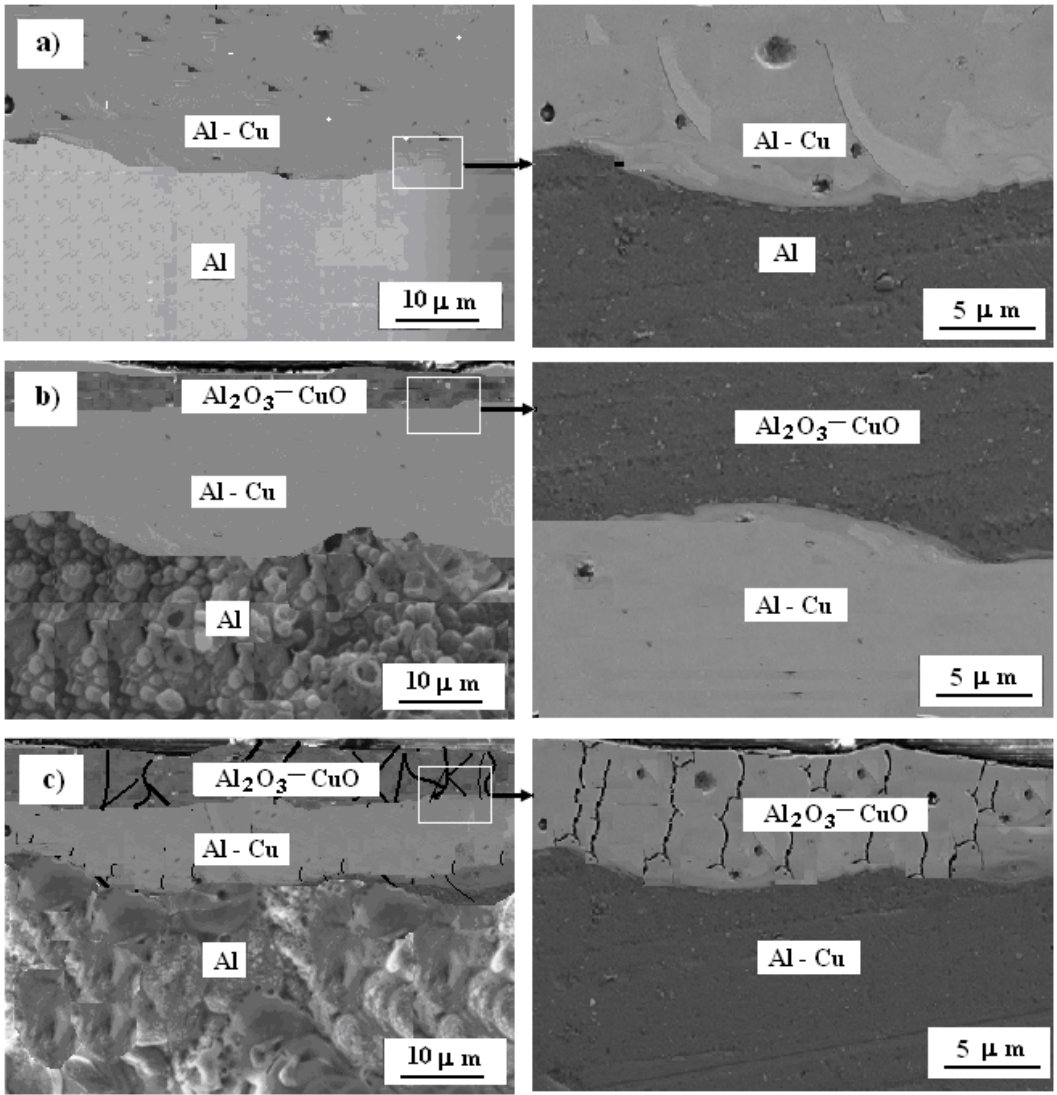
Figure 7. SEM images of cross-section of samples: ( a ) before and after heat treatment at: ( b ) 400 °C or ( c ) 600 °C in air atmosphere.